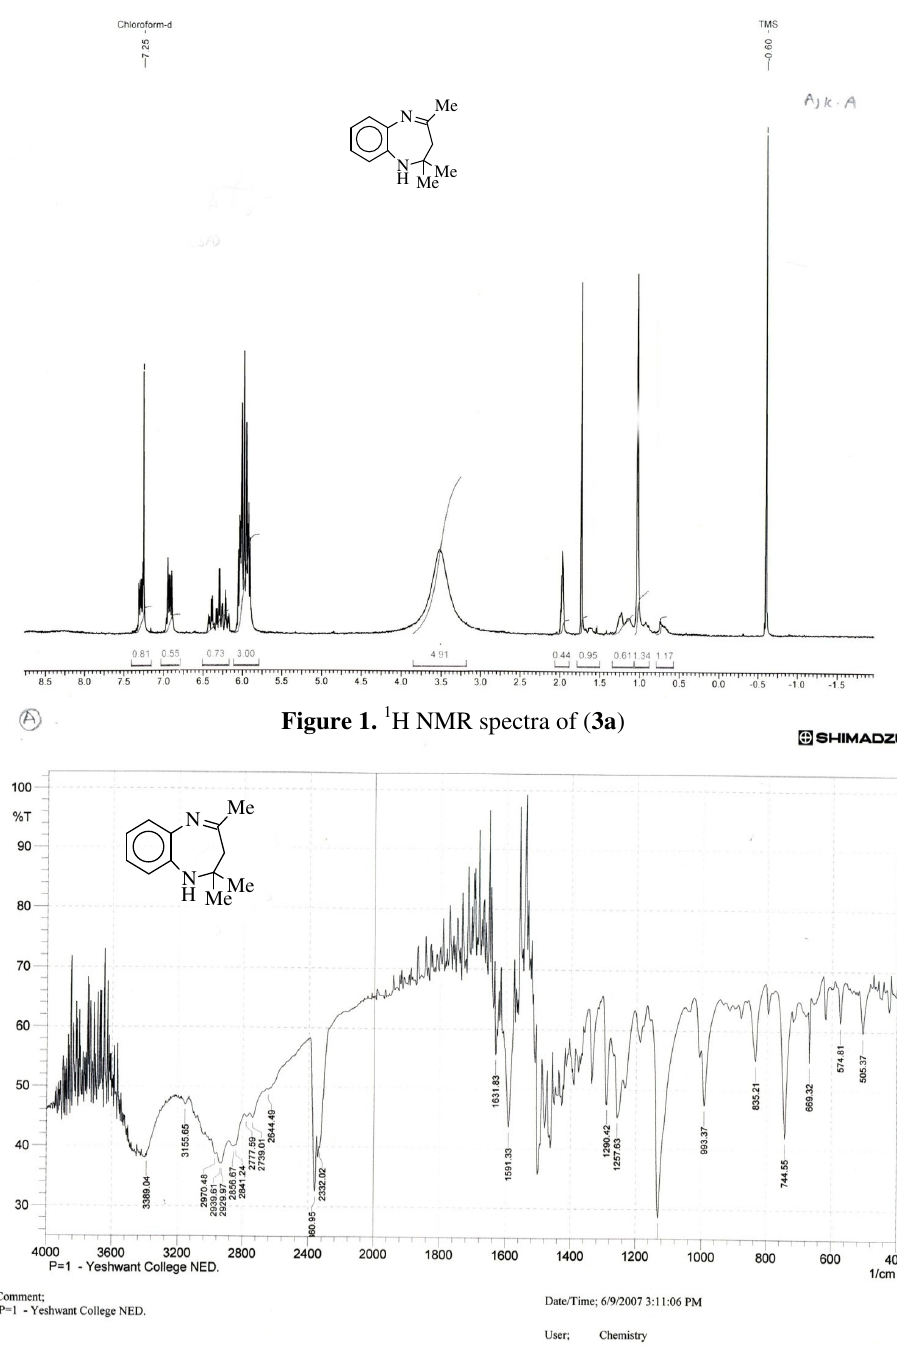
Figure 2. IR spectra of ( 3a